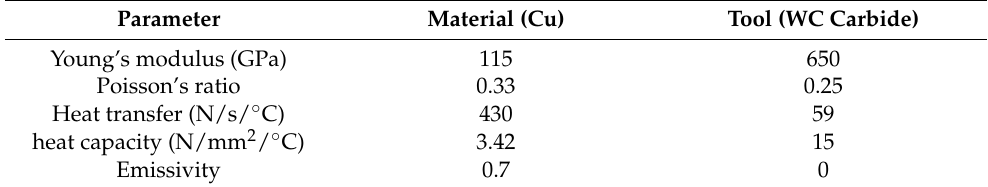
Table 1. The thermodynamic material attribute parameters of pure copper and the tool.